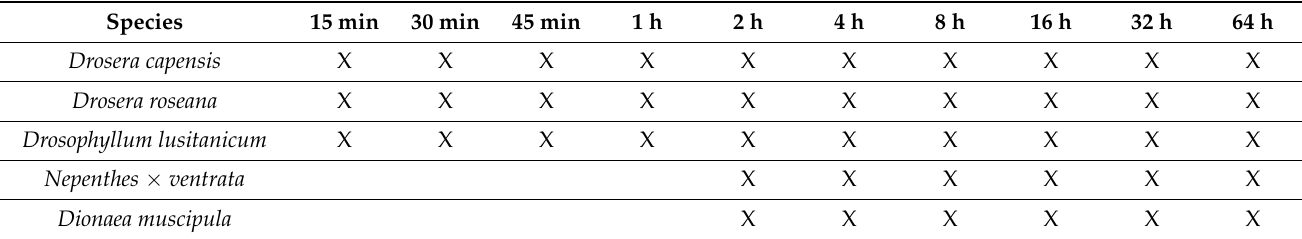
Table 4. Plant species and observed time points of the endocytosis marker treatment with FITC-BSA. Preliminary experiments had shown that no uptake occurred in N. × ventrata and D. muscipula during the first two